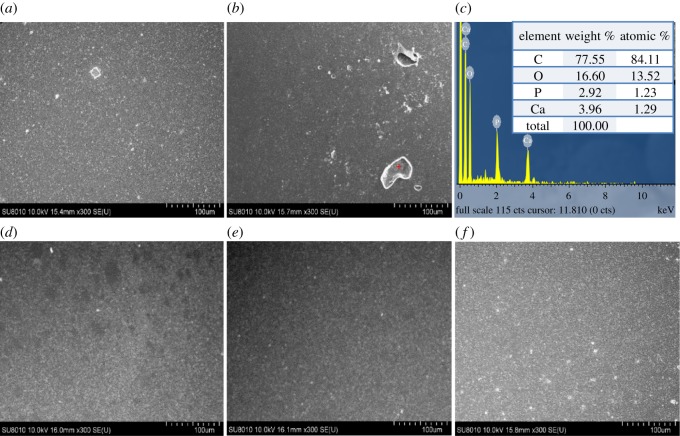
SEM images and EDX analysis of PMMA composite. SEM micrographs of PMMAn10 (a) and PMMAn20 (b) show some bright areas on the surface which were identified as the agglomeration of nHAP particles by EDX (c). PMMAg10 (d) and PMMAg20 (e) had a smooth and homogeneous surface similar to PMMA (f).